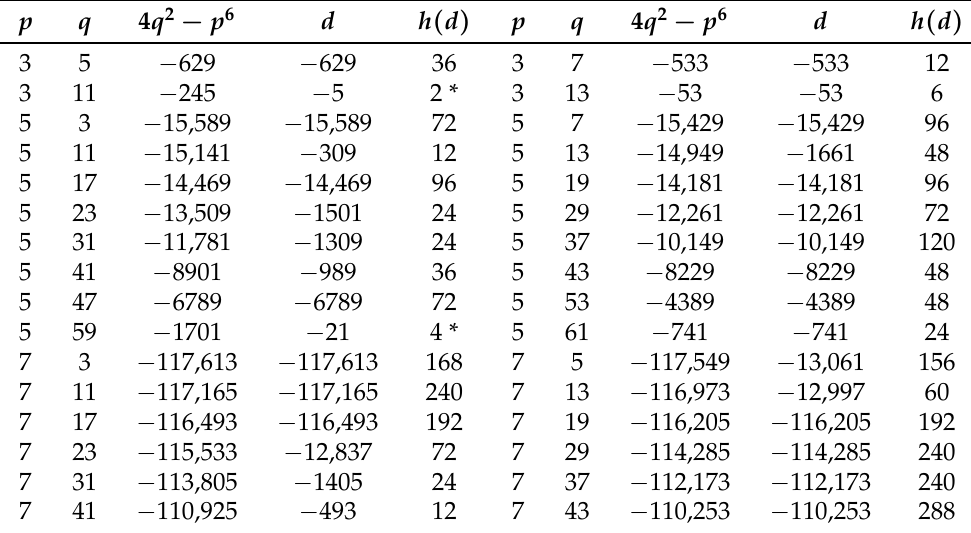
Table 4. Numerical examples for n =